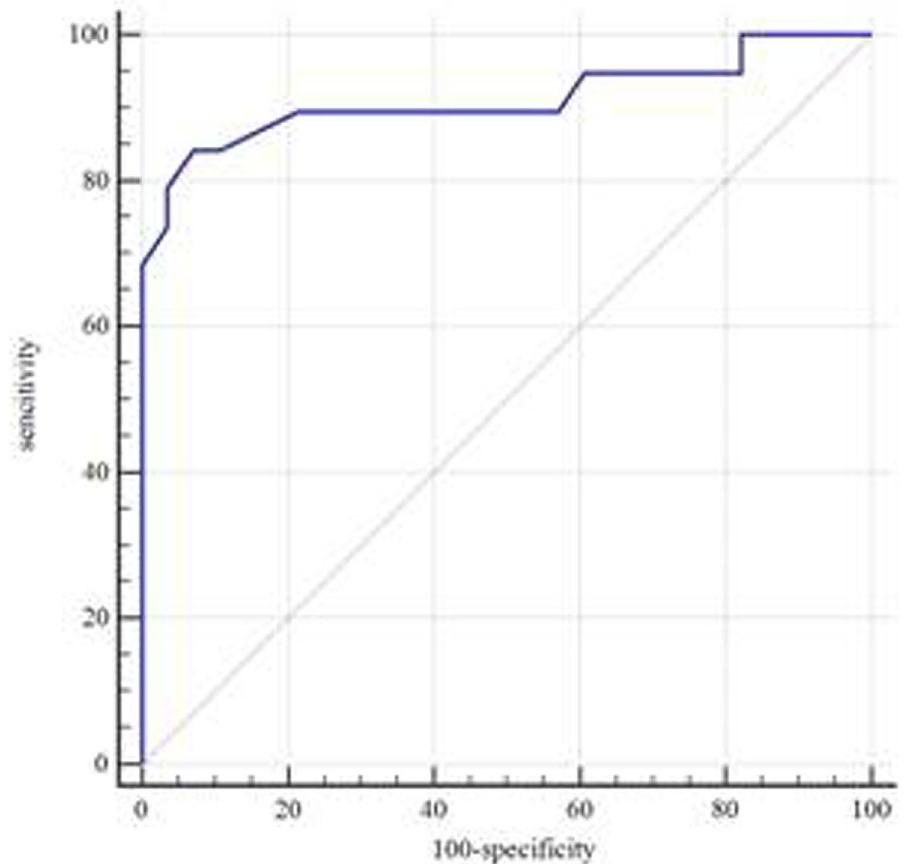
Figure 2. ROC curve of ergonovine provocation test of radial artery for the diagnosis of CAS. Notes : ROC: receiver operator characteristic; CAS: coronary artery